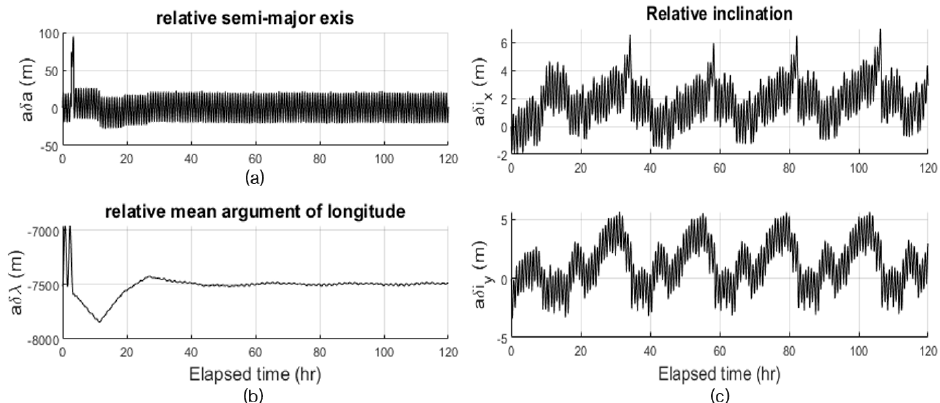
Figure 8. Simulation results of the relative orbit control algorithm. Relative semimajor axis ( a ), relative mean argument of longitude ( b ), and relative inclination vector elements ( c ) over elapsed time. Figure 9 denotes the control profile of the relative orbit control (a) and the accumulated Δ𝑣 used for relative orbit control (b). To correct the initial relative position error of the deputy satellite, Δ𝑣 of 75 mm/s was used in the first in-plane maneuver. After the formation was stable, a thrust of approximately 2 mm/s was used for each in-plane maneuver. Out-of-plane maneuvers were performed once every 20 orbital cycles, and the value of Δ𝑣 used in each maneuver was approximately 7 mm/s. The average Δ𝑣 per day used for relative orbit control was approximately 11 mm/s, which is within the performance range of the Hall effect ion thruster. Figure 9. Simulation results of the relative orbit control algorithm. Thrust profile used for relative orbit control ( a ) and accumulated Δ𝑣 ( b ) over elapsed time. The blue dotted line in ( a ) is the in- plane control thrust and the black solid line is the out-of-plane control thrust. 3.3. Performance Analysis of Thrusters for Orbit Control In microsatellites, cold gas or ion thrusters are used for orbit control, considering the mounting space constraint and the thrusters’ safe operation [33]. The cold gas thruster is relatively fine in terms of cost and thrust magnitude, and the ion thruster is superior in specific impulse ( 𝐼 (cid:3046)(cid:3043) ), indicating the efficiency of the thruster. Therefore, a thruster